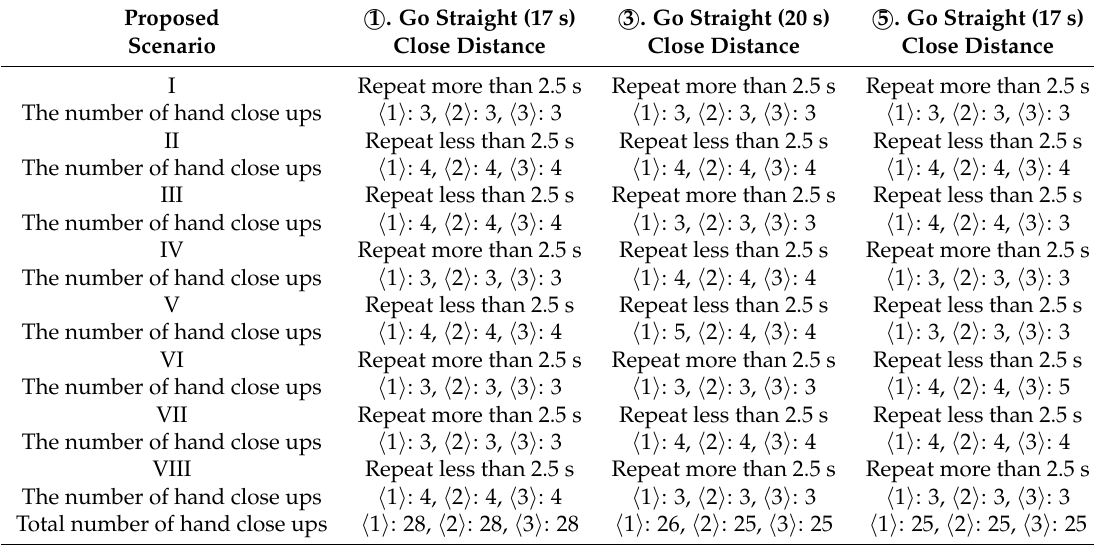
Table 2. Proposed scenarios for measuring the distance and time of movement between a driver’s hand and the three infrared sensors while driving straightfor each of the eight drivers. (s: seconds, The number of hand colse ups: the number of driver A’s hand close ups, (cid:104) 1 (cid:105) : infrared sensor (cid:104) 1 (cid:105) , (cid:104) 2 (cid:105) : infrared sensor (cid:104) 2 (cid:105) , (cid:104) 3 (cid:105) : infrared sensor (cid:104) 3 (cid:105)